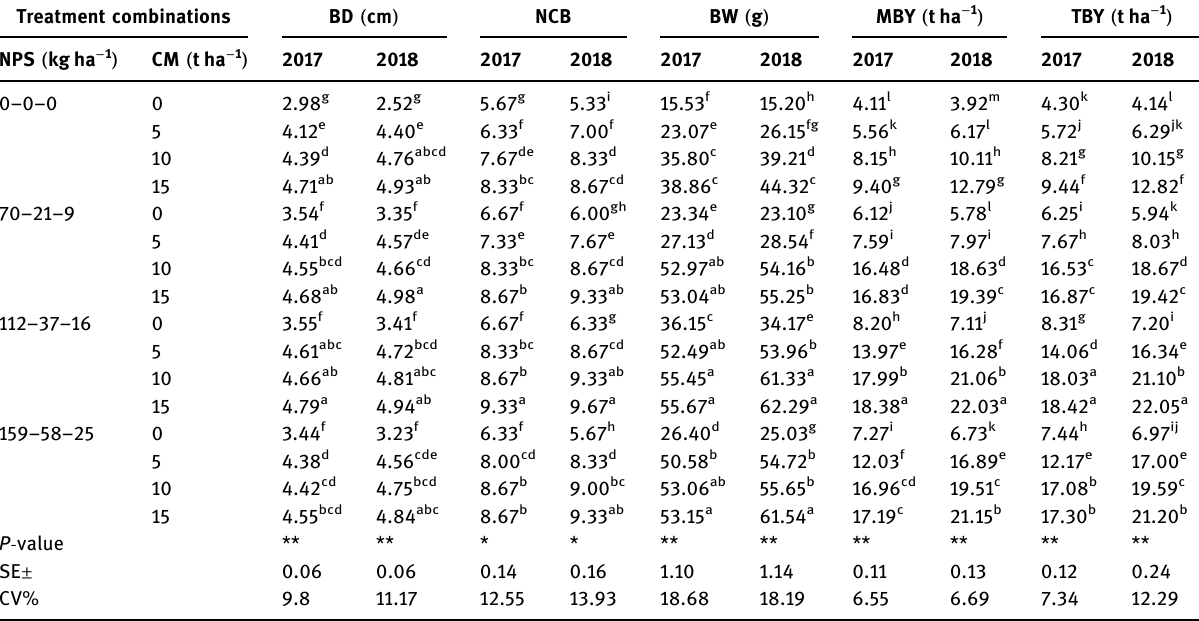
Table 6: E ff ect of NPS inorganic fertilizers and cattle manure application on bulb yield related parameters of garlic in 2017 and 2018 in northwest Ethiopian highlands Treatment